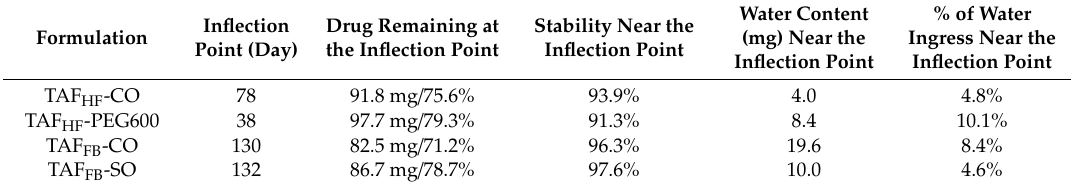
Table 3. The inflection points determined by fitting the degradation profiles of various TAF formulations to the two-line models. Mass quantities of drug remaining and TAF stability at the inflection points are